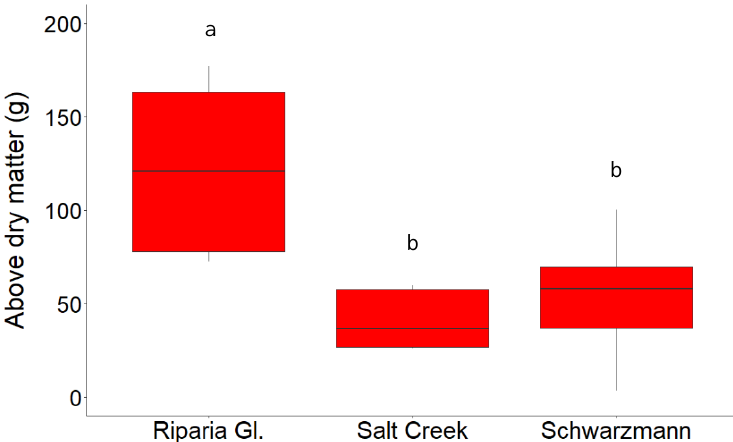
Figure A3. Shoot dry matter (g) in grapevine rootstocks inoculated with AM fungi at two years of field cultivation. Letters above boxes indicate significant differences at p < 0.05.